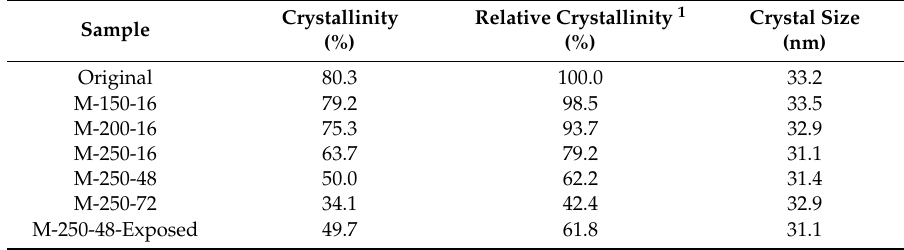
Table 3. Crystallinity percentages and crystal size values of NH 2 -MIL-125(Ti) before and after heat treatment in air under different conditions. The values for M-250-48 after 24 h in contact with water are included.